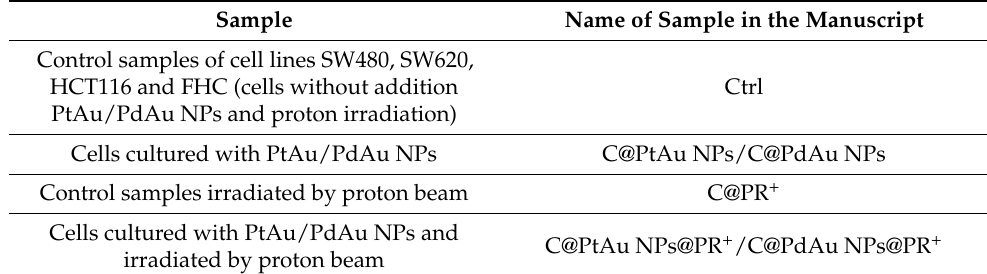
Table 1. Description of the investigated